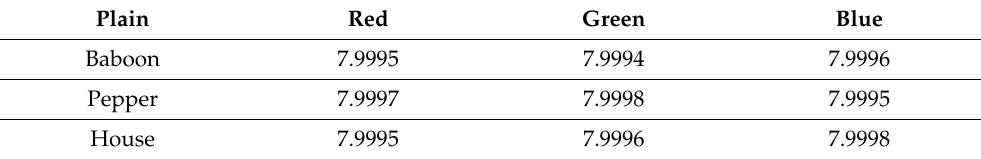
Table 4. The information entropy (bits) for different color components of encrypted images.